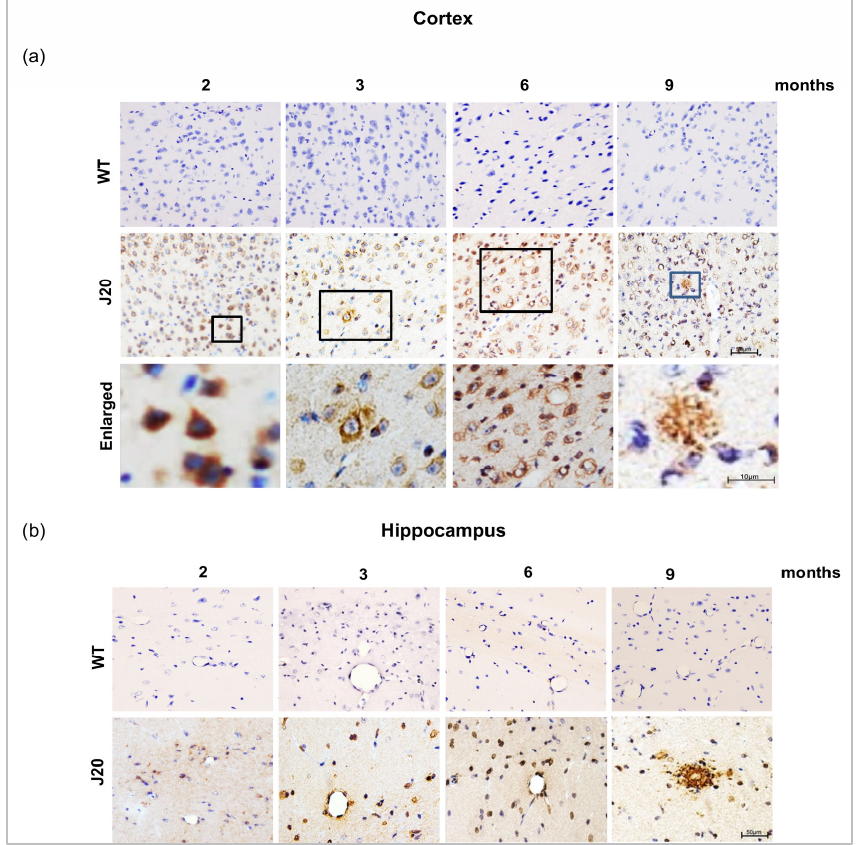
Figure 2. A β peptide immunoreactivity and vascular deposition of A β in J20 mice brain. ( a , b ) A β immunoreactivity in the cortex and the hippocampus of both WT and J20 mice brains at 2, 3, 6, and 9 months of age. A β peptides were predominantly located in the hippocampal and cortical region in J20 mice but not in WT mice brains. All boxed areas were magnified. Scale bar = 10 µ m. Intraneuronal A β at 2 months and extravascular A β deposition in parenchyma at 9 months. M indicates month. Scale bar = 50 µ